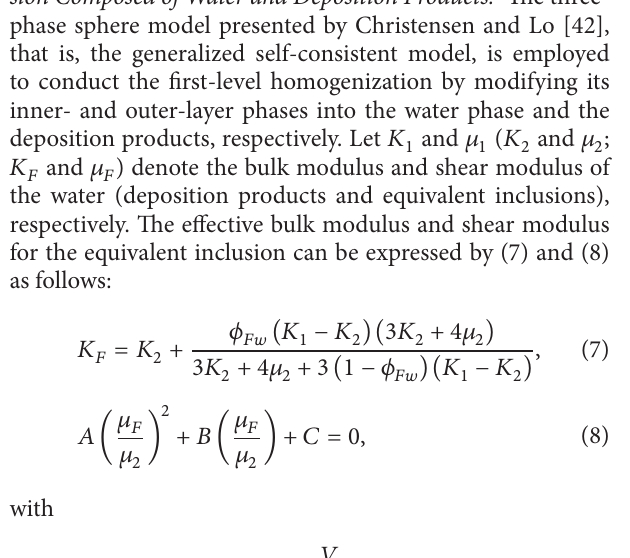
Figure 1: Micromechanical model for saturated concrete healed using EDM with interfacial transition zone